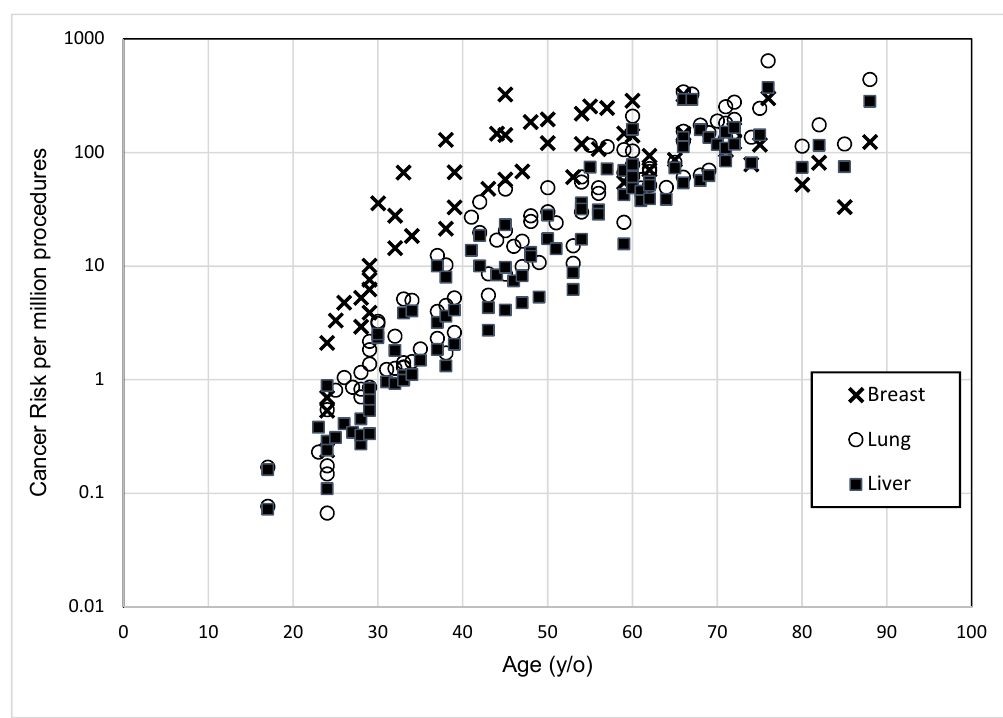
Figure 3. Relationship between cancer risk per million procedure with the age of the subjects.